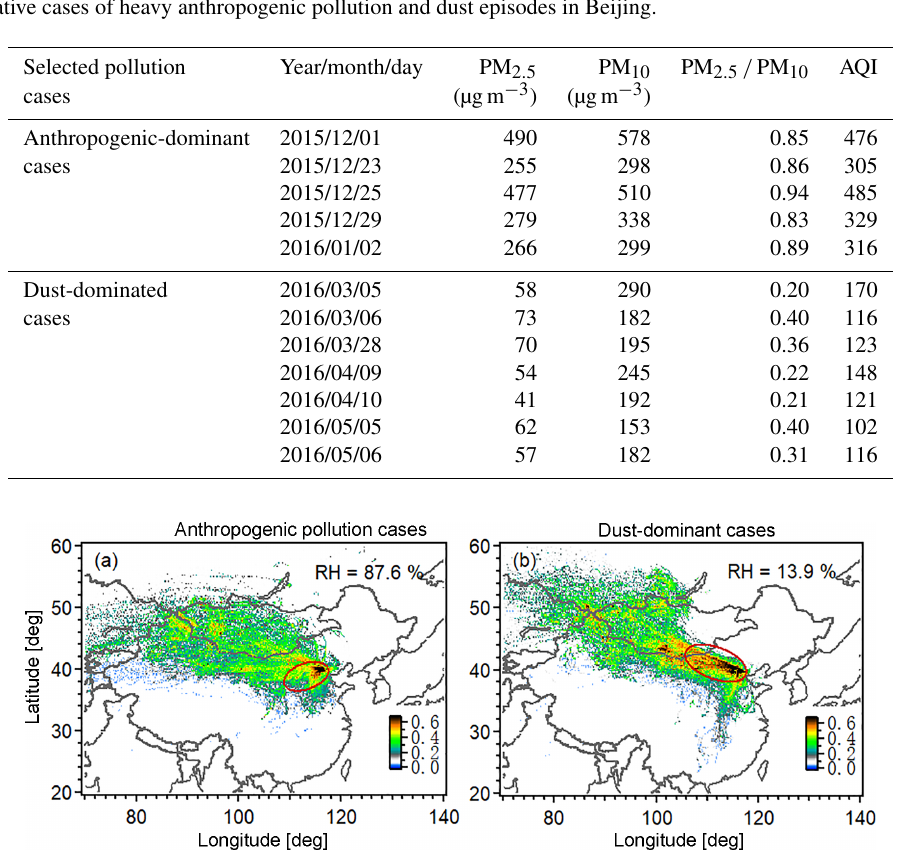
Table 1. Representative cases of heavy anthropogenic pollution and dust episodes in Beijing.